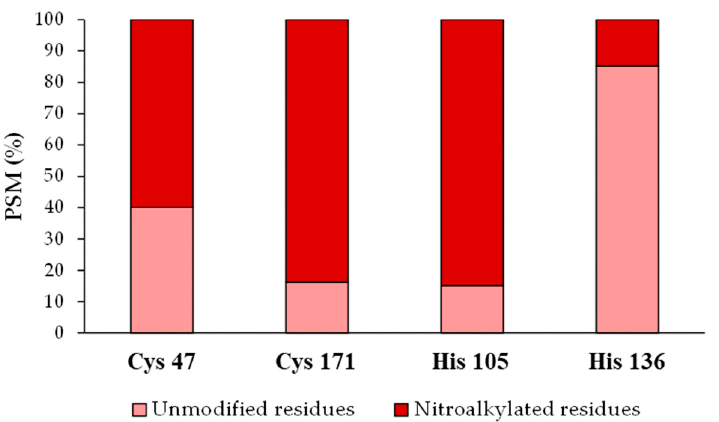
Figure 6. Relative quantification of the recombinant Tsa1 nitroalkylated residues after the treatment with NO 2 -OA. This figure shows the relative percentage (%) of the PSM identified for Cys 47, Cys 171, His 105 and His 136 residues in either the modified or the unmodified form. PSM: number of peptide spectrum matches. His: histidine, Cys: cysteine.